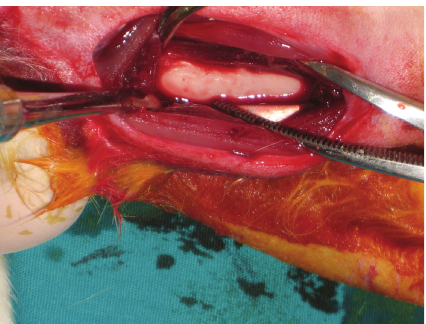
Figure 1: Image of the fibula after dissection.